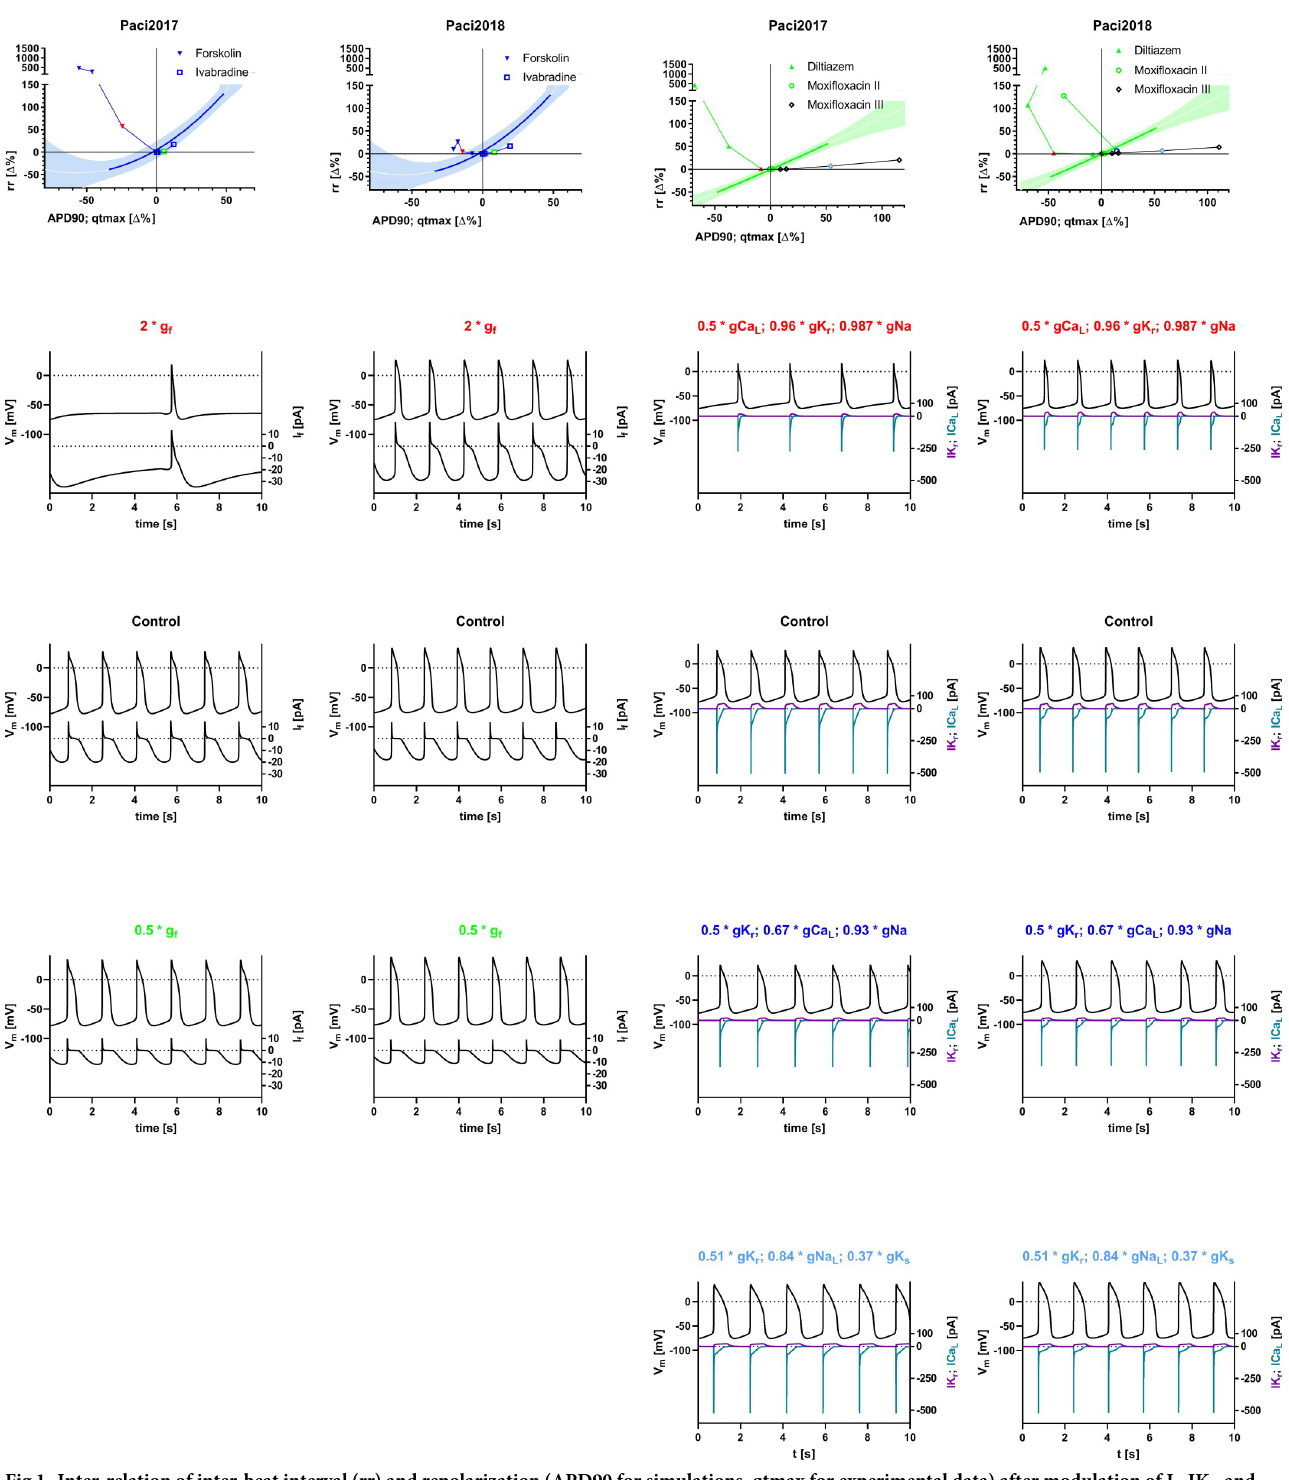
Fig 1. Inter-relation of inter-beat interval (rr) and repolarization (APD90 for simulations, qtmax for experimental data) after modulation of I f , IK r , and ICa L with Ivabradine, Forskolin, Diltiazem, and Moxifloxacin, including reported off-targets. First row: Blue: Data relating to mechanisms primarily affecting rr (reduction and augmentation of I f with Ivabradine and Forskolin). Green: Data relating to mechanisms primarily affecting repolarization (reduction of ICa L or IK r with Diltiazem and Moxifloxacin). Shaded areas: 90% prediction intervals for polynomial fit (solid lines) of experimental data as published in [1]; solid green and blue lines within shaded areas indicate dynamic range of experimental data. The graphical representation of experimental data is modified from